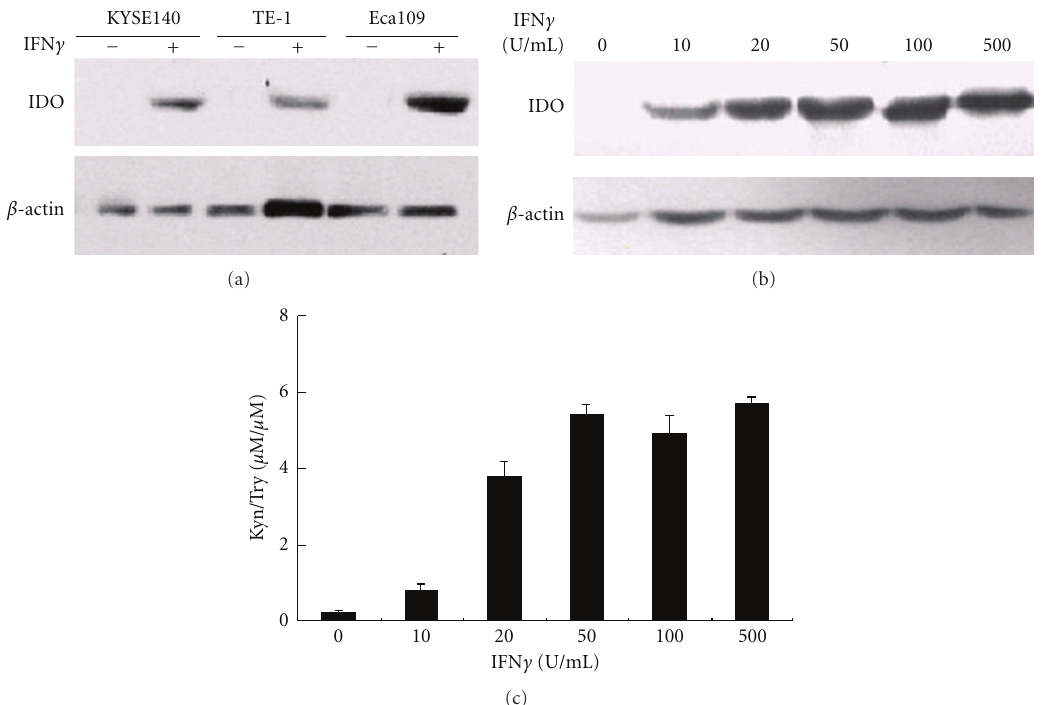
Figure 4: E ff ect of IFN γ on IDO expression in the esophageal carcinoma cell lines. Esophageal carcinoma cell lines Kyse 140, TE-1, and Eca109 were treated with or without 100 U/mL IFN γ for 24 hr, and expression of the IDO protein was assessed by western blot (a). IFN γ induced IDO protein expression in Eca109 cells in a dose-dependent manner. Eca109 cells were cultured in the presence of indicated concentrations of IFN γ for 24 hr, IDO expression was analyzed by western blotting (b); the supernatants of Eca109 cells were analyzed for Kyn and Trp production using HPLC (c). Columns, mean of three independent experiments. Bars, SD. by low levels of IFN γ . The finding that ESCC tumor cell